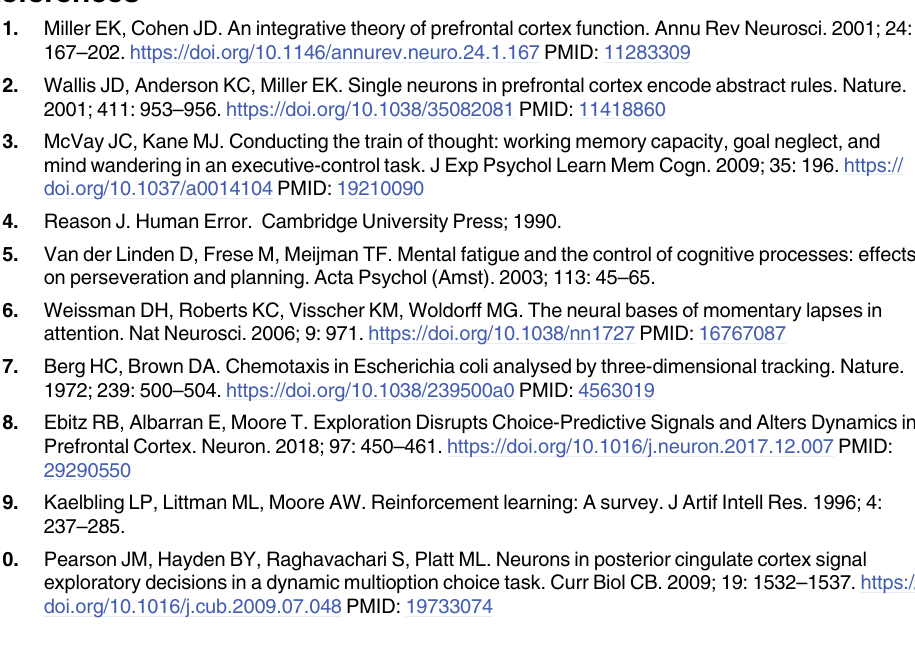
Left) State probabilities for each individual session (dark gray) and label-shuffled data (light gray).